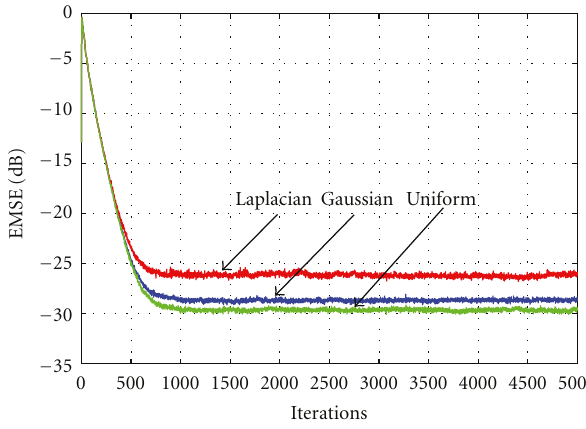
Figure 8: Learning curves of the proposed algorithm in di ff erent noise environments scenarios for α = 0 . 8 and SNR of 10dB.